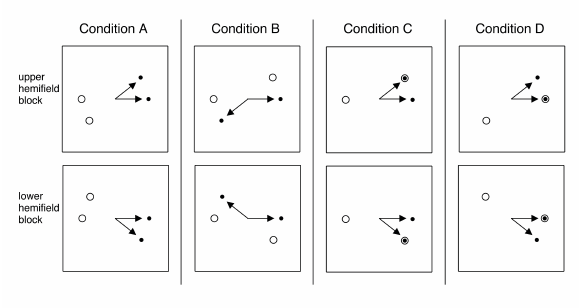
Figure 1. Illustration of conditions and alternate-trial locations, for a subject in whom the key horizontal saccade is located in the right hemifield. Upper row shows blocks with alternate locations in the upper hemifield, bottom row shows blocks with alternate locations in the lower hemifield. Clear rings indicate stimulus locations, small black discs indicate saccade goals located at the tip of the arrows depicting the desired saccade. In condition A (leftmost column), horizontal antisaccades are paired with alternate trials with nearby antisaccade goals. In condition B (left middle column), horizontal antisaccades are paired with alternate trials with nearby antisaccade stimuli. In condition C (right middle column), horizontal antisaccades are paired with nearby prosaccades. In condition D (rightmost column), horizontal prosaccades are paired with alternate trials with nearby antisaccade